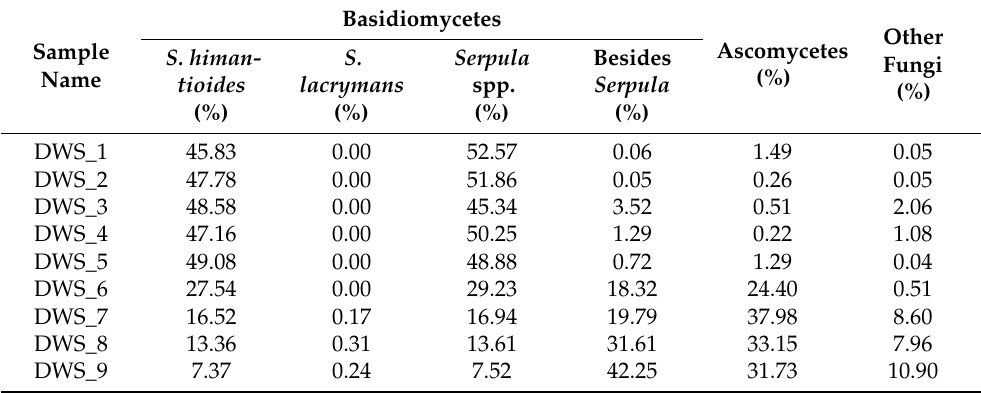
Table 1. Percentage of reads of fungi detected by amplicon sequencing using the fungal community primer set.